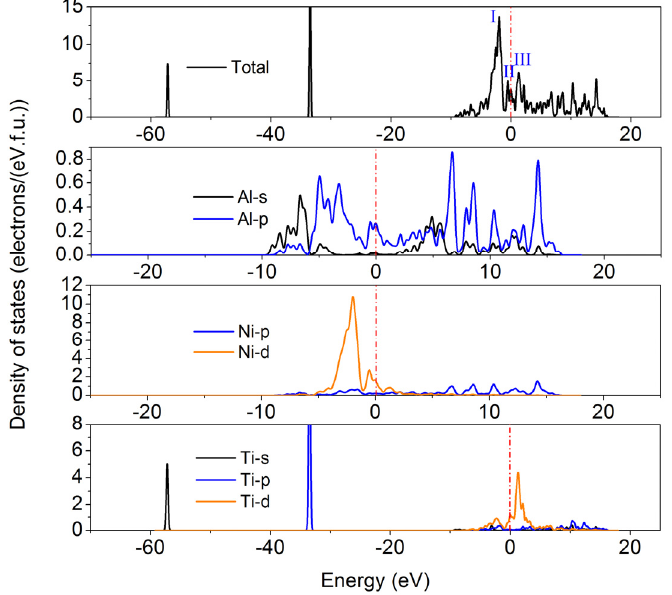
Figure 10. Total and partial density of states of AlNi 2 Ti compound. The Fermi level is indicated by a red vertical line.